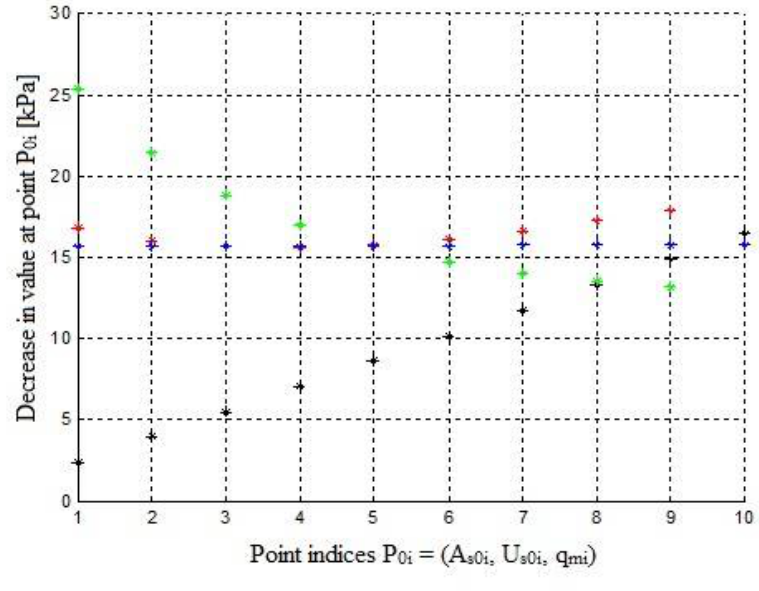
Figure 4. Values of vacuum drops calculated at points P 0i . The value of the differential (Figure 5) is calculated at the point with index “ i ”. Legend for Figures 4 and 5.